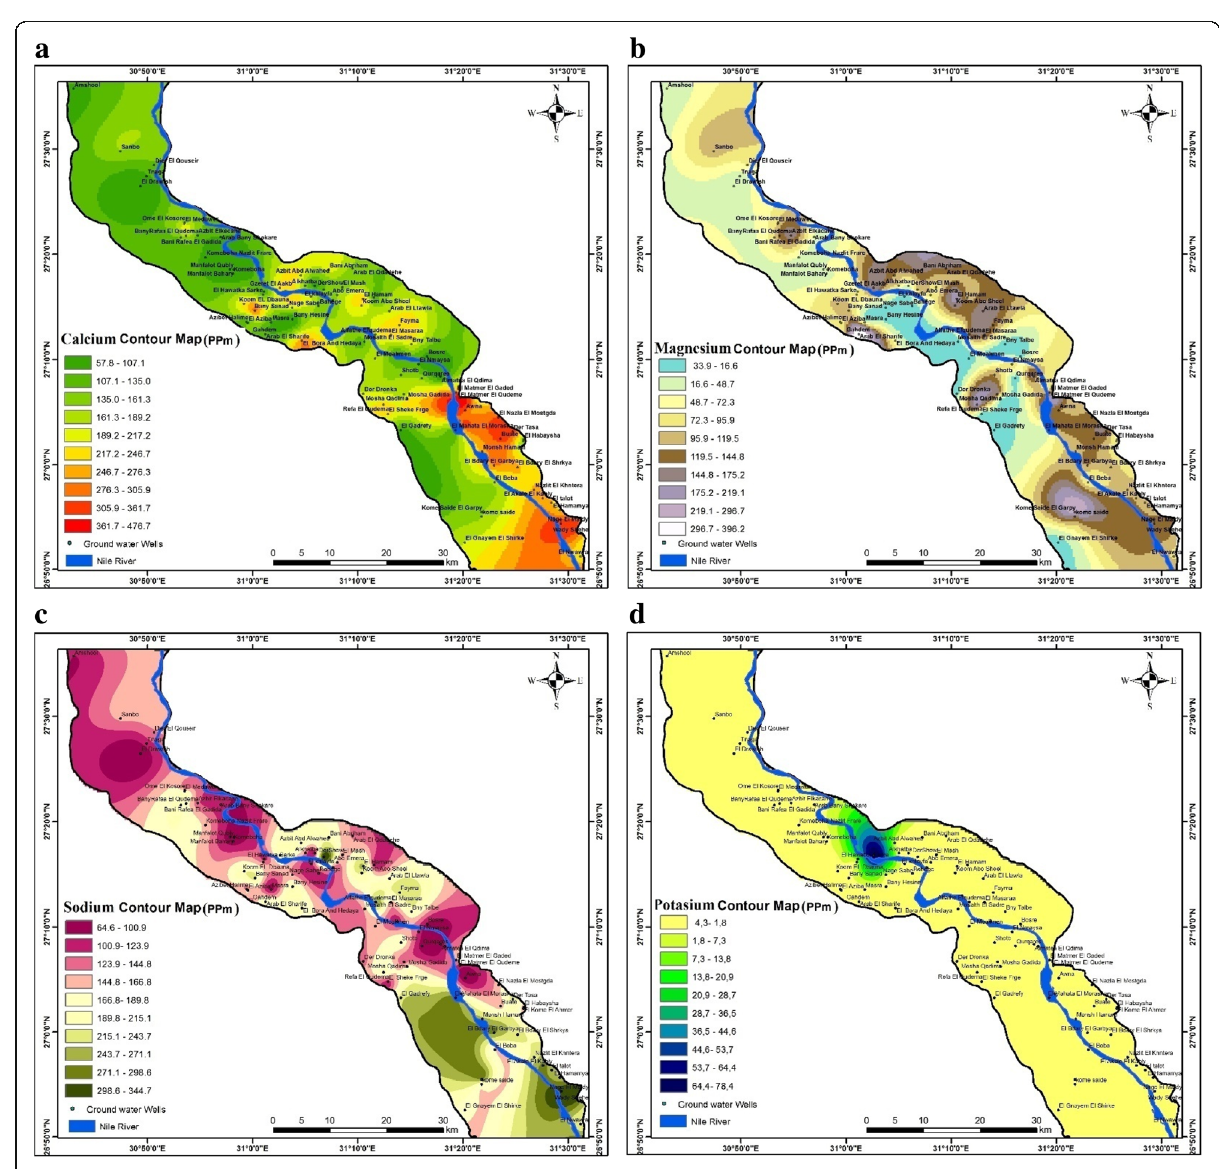
Fig. 8 Iso-concentration maps showing spatial variation in a Ca, b Mg, c Na, and d K in the study area (values in milligrams per